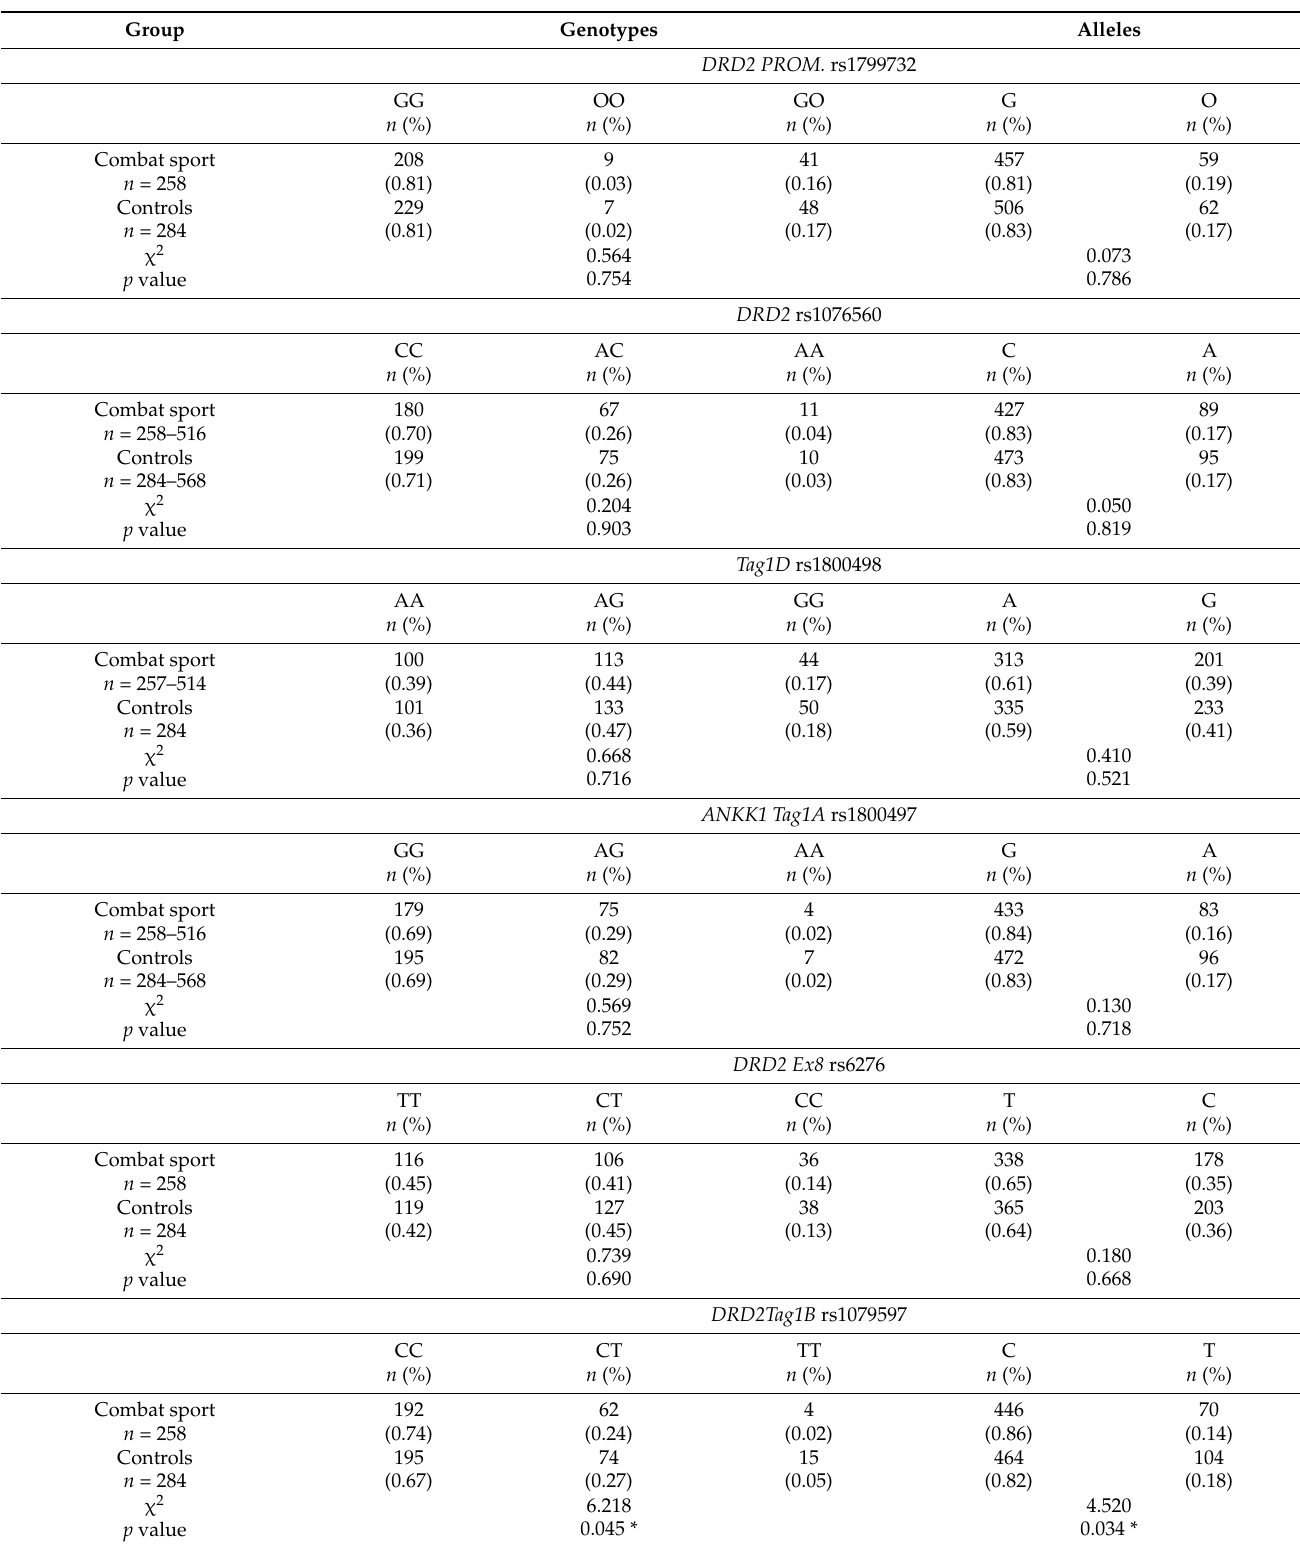
Table 2. Frequency of genotypes and alleles of the DRD2 PROM. rs1799732, DRD 2 rs1076560, DRD2 Tag1D rs1800498,